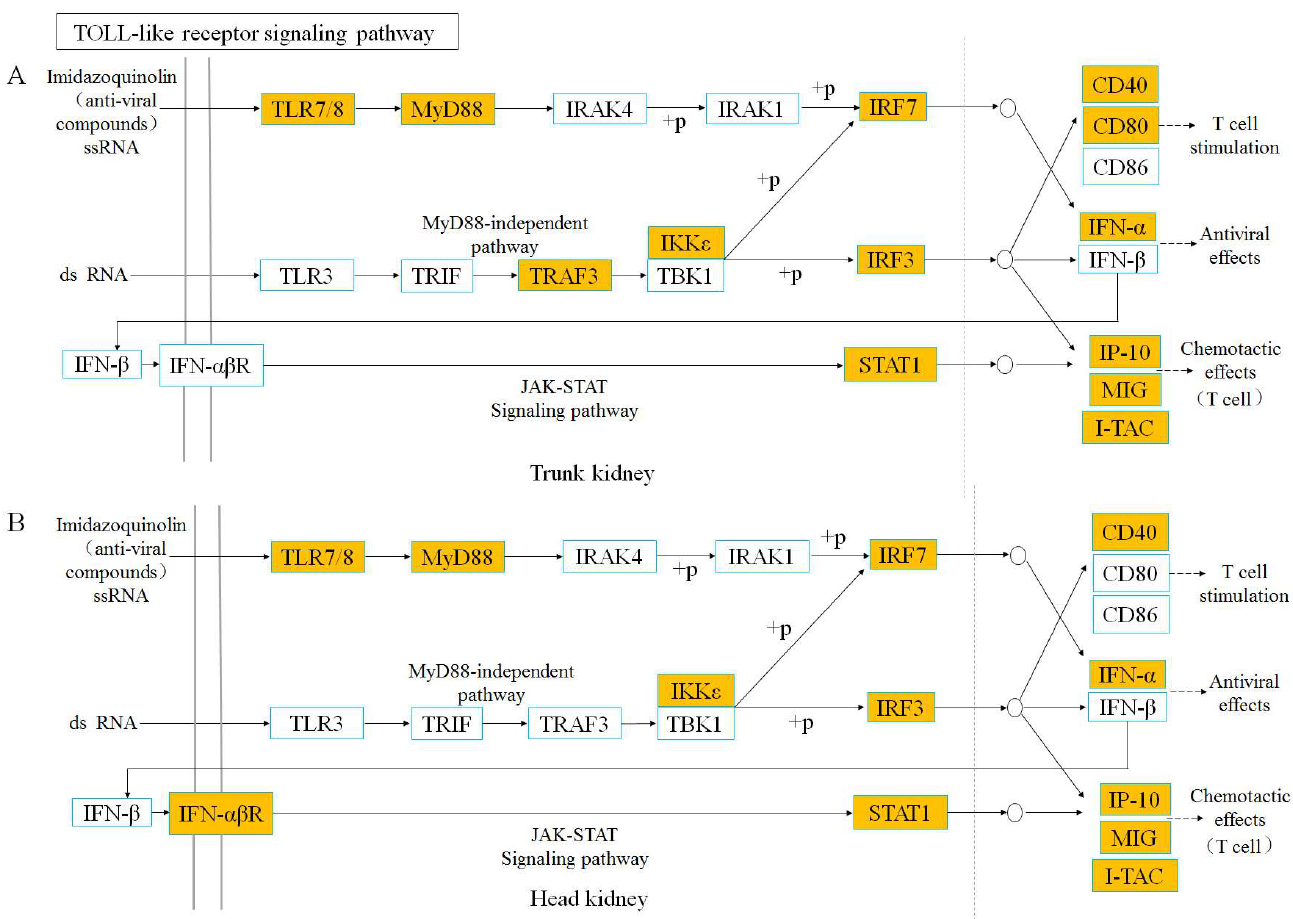
Figure 5. TOLL-like receptor signaling pathway was analyzed and simplified from KEGG. Genes marked in orange represent DEGs in RNA-seq.